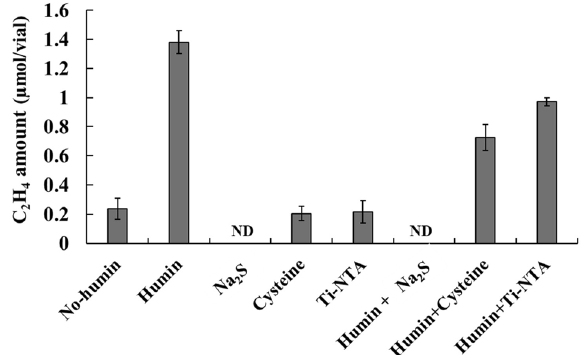
Figure 5. Effect of reducing agents on ARA of the no-humin consortium. The no-humin consortium tested with addition of cysteine or Ti-NTA as reducing agent showed less ARA than the no-humin consortium tested with humin (Kamajima humin, positive control). ARA of the no-humin consortium tested with cysteine or Ti-NTA was increased by the addition of humin, although the value was still lower than the positive control. The reducing agent Na 2 S inhibited ARA of the consortium regardless of the addition of humin. ND not detected.